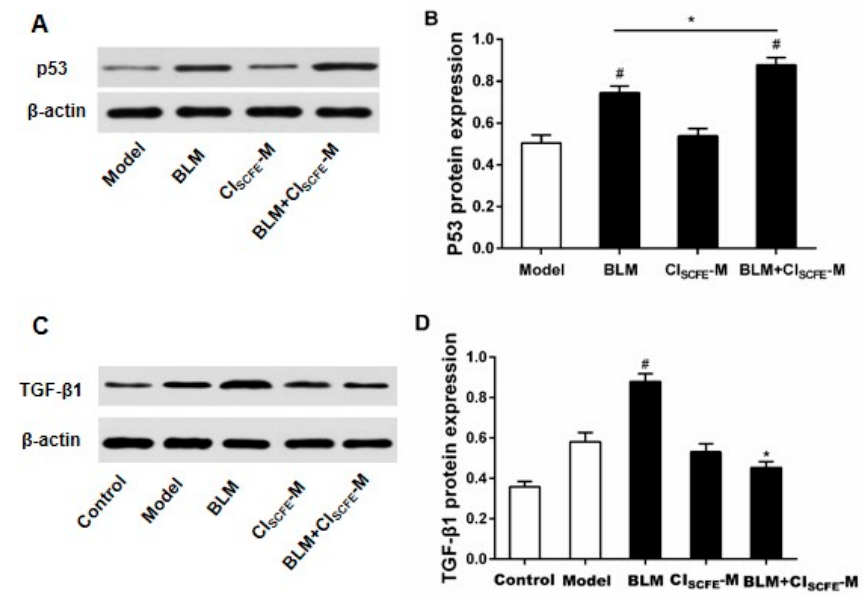
Figure 8. Effect of CI SCFE and BLM treatment on protein-related expression in H22 tumor-bearing mice. The protein expressions of p53 ( A ) and tumor growth factor-beta (TGF- β )1 ( C ) were determined by Western blot. Data ( B , D ) are presented as mean ± SEM ( n = 4). # p < 0.05 vs. model group; * p < 0.05 vs. BLM group.